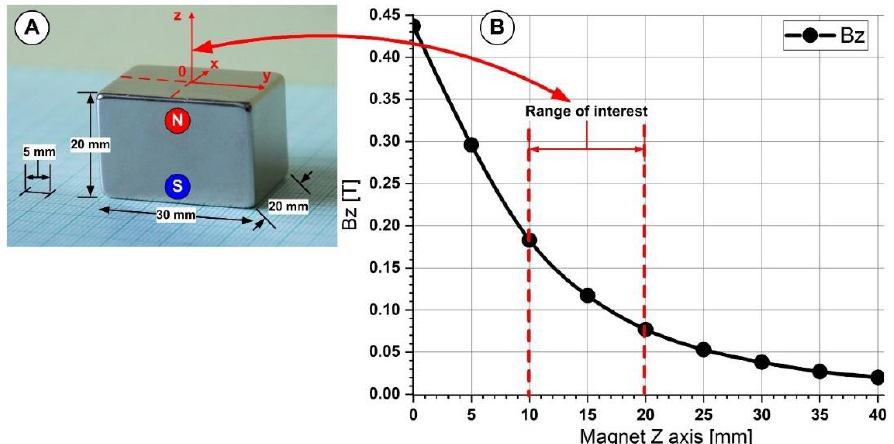
Figure 3. A magnetic field was generated by the NbFeB50 permanent magnet used in the experimental investigation. ( A ). The magnet’s dimension and axis association. A used permanent magnet has polarization along the Z -axis. ( B ) The figure depicts the magnetic field measured at various Z -axis positions with the F.W. Bell Gaussmeter, model 5080.